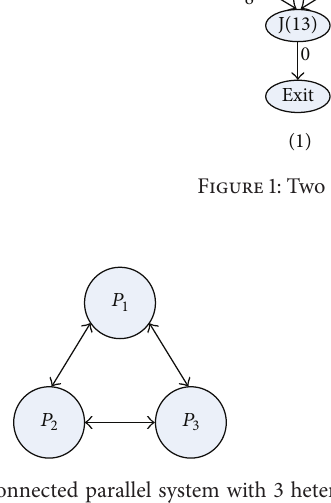
Figure 4: Illustration of molecular structure change for on-wall ineffective collision.